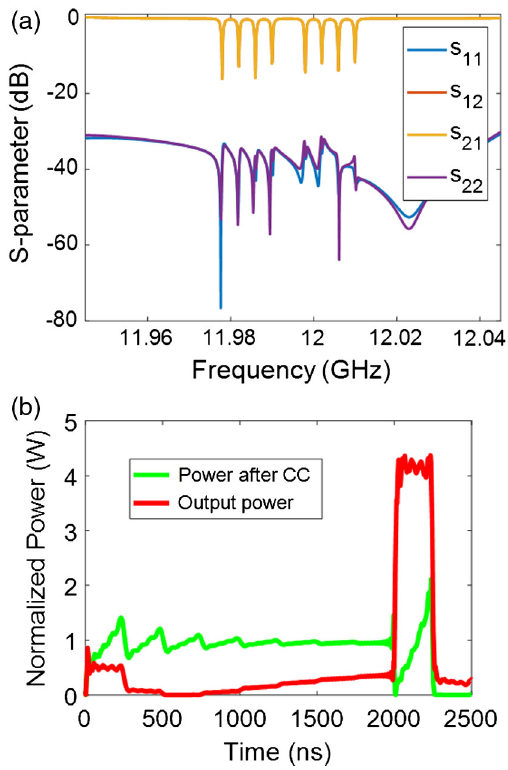
FIG. 14. (a) S-parameters of the correction cavity chain and (b) the output pulse with simulated S-parameters of correction cavity chain from HFSS and storage cavity with unloaded Q-factor of 1 . 77 × 10 5 and coupling coefficient of